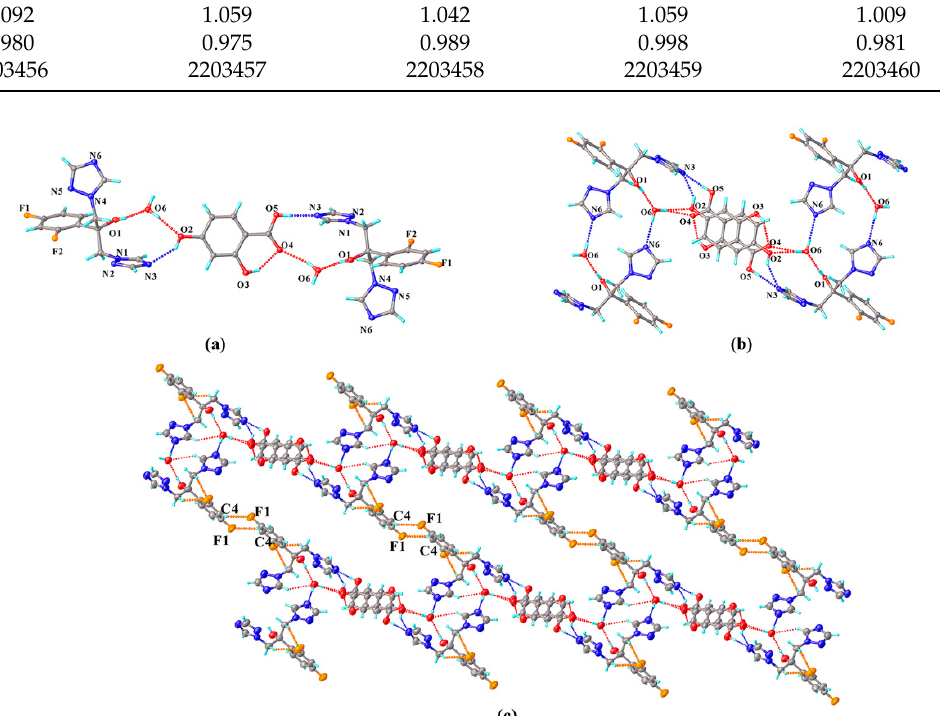
Figure 2. ( a ) Hydrogen-bonding interactions in two asymmetric units; ( b ) the centrosymmetric system composed of four FLZ molecules, two 24DHB, and four water molecules; ( c ) hydrogen-bonded chains stabilized by C 4 − H 4 . . . F 1 hydrogen bonds and other weak